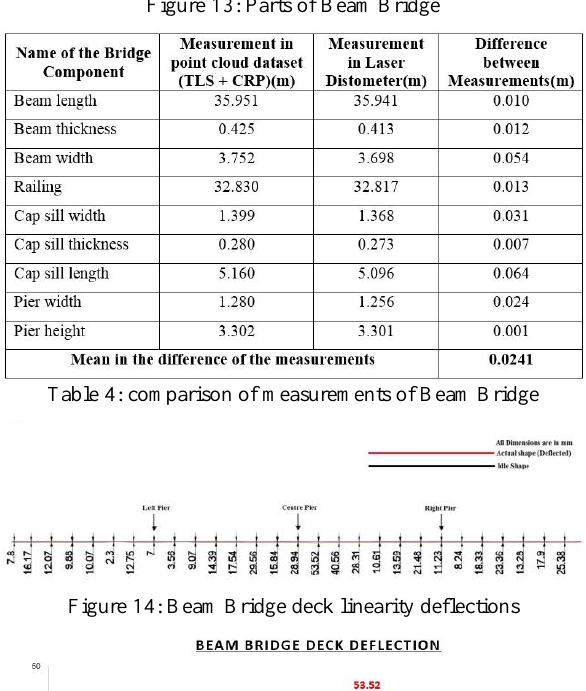
Figure 13: Parts of Beam Bridge